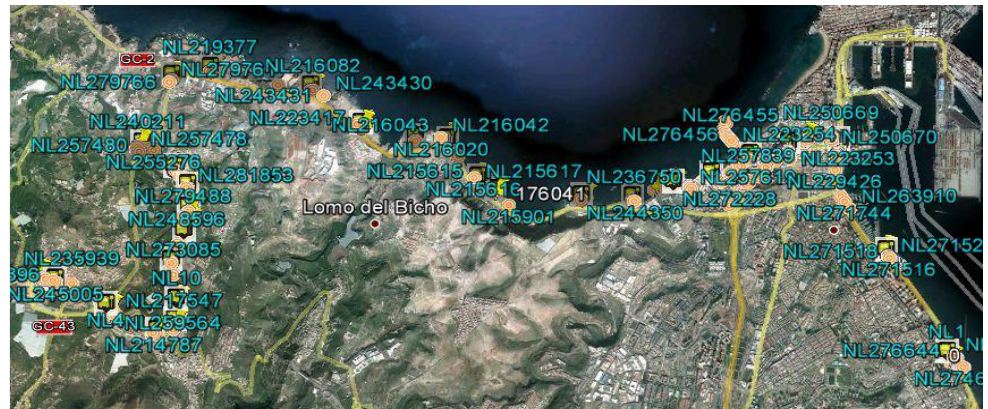
Figure 2. Aerial view of the geographic area of the route being studied. The green tags represent vehicle position readings with a velocity of zero. The orange markings represent the centroids of the groups of readings with a velocity of zero. The yellow icons represent scheduled bus stops of the